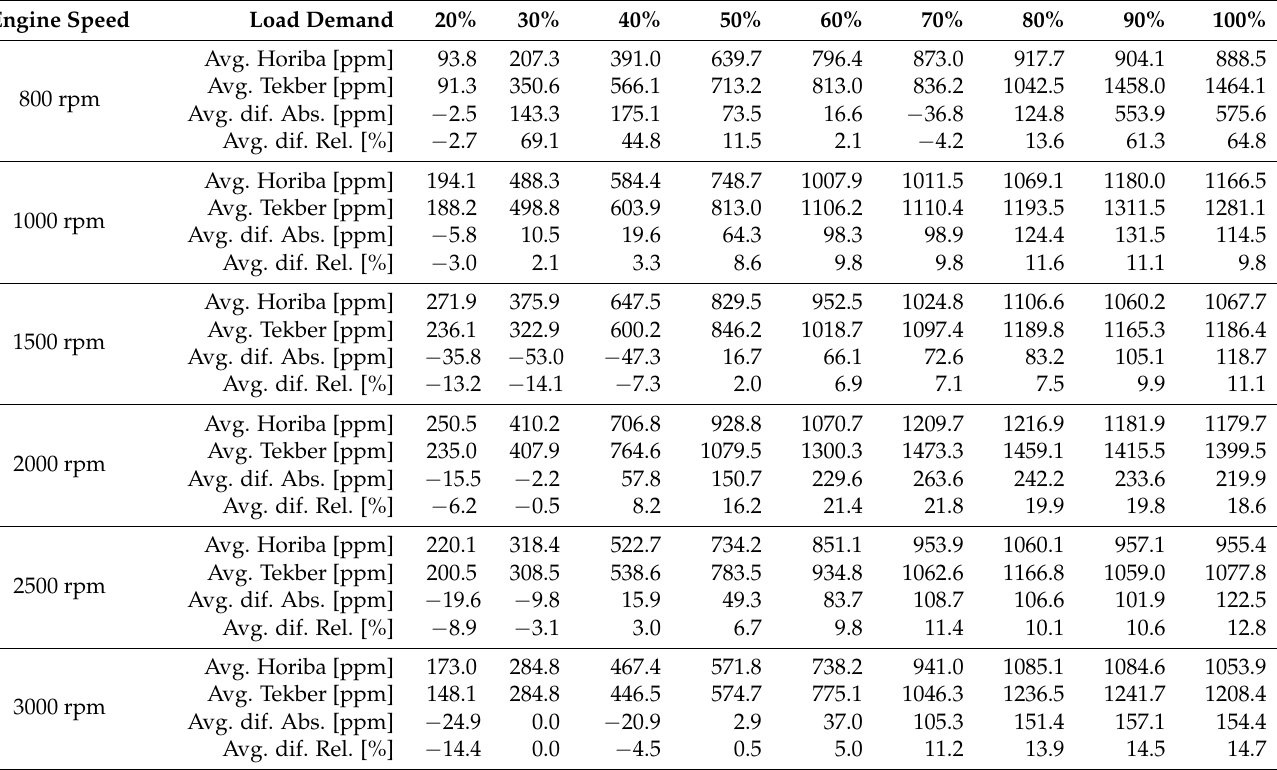
Table A8. Summary of the average concentration and differences between Horiba and Tekber equipment with EGR